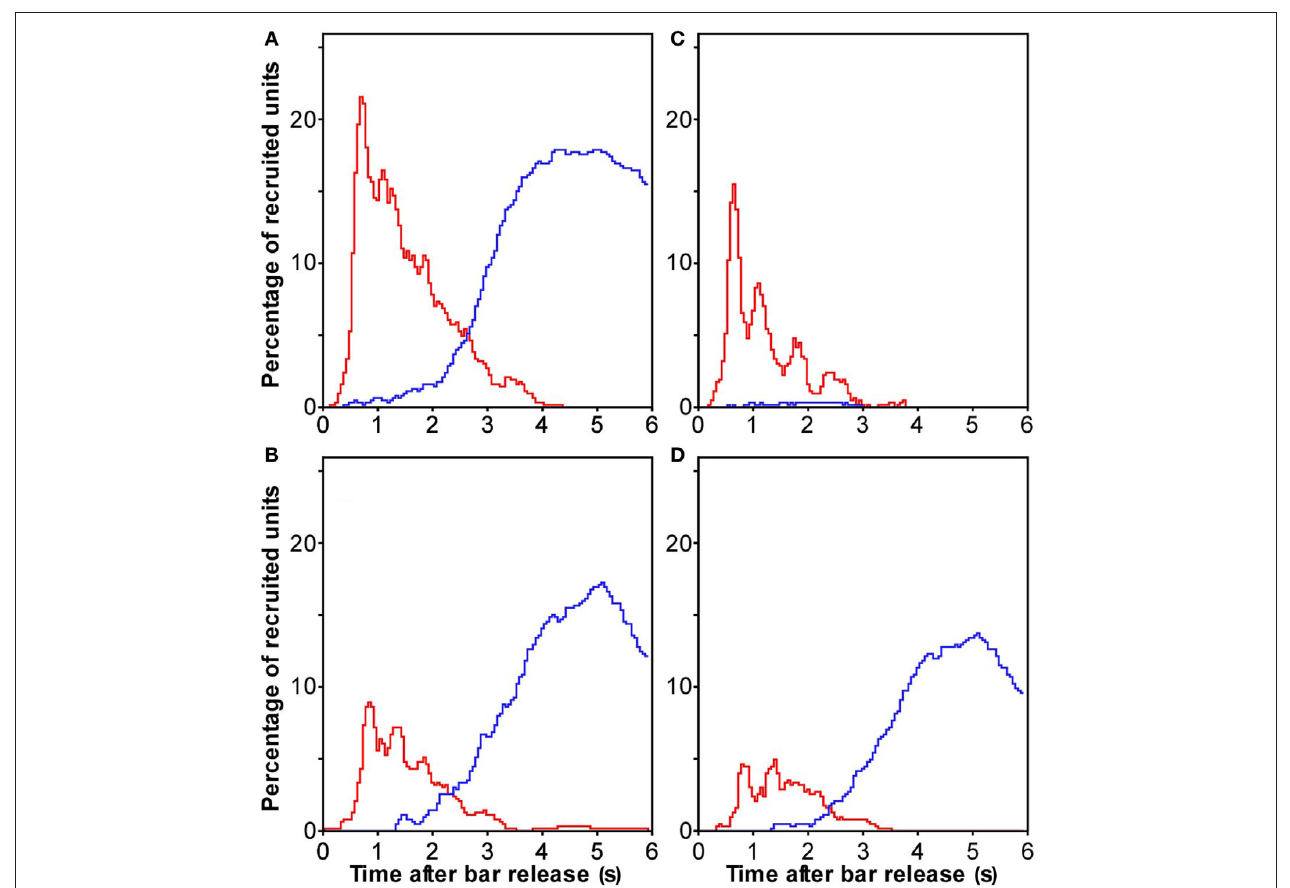
firing. Conventions as in Figure 4 . (B) The same comparison for the small and no-reward conditions. (C) The same comparison for the large and small reward conditions. (D) Multiunits whose firing differed both between the large and no-reward condition and between the small and no- reward